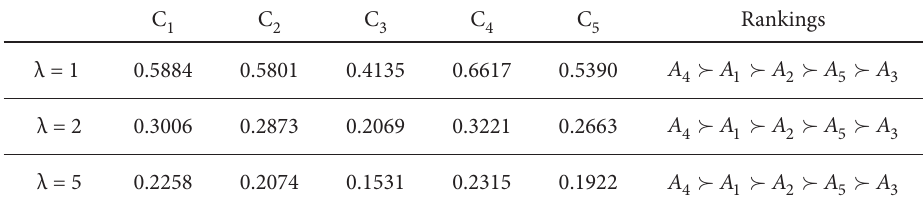
Table 5. Generalized expected values for different λ C 1